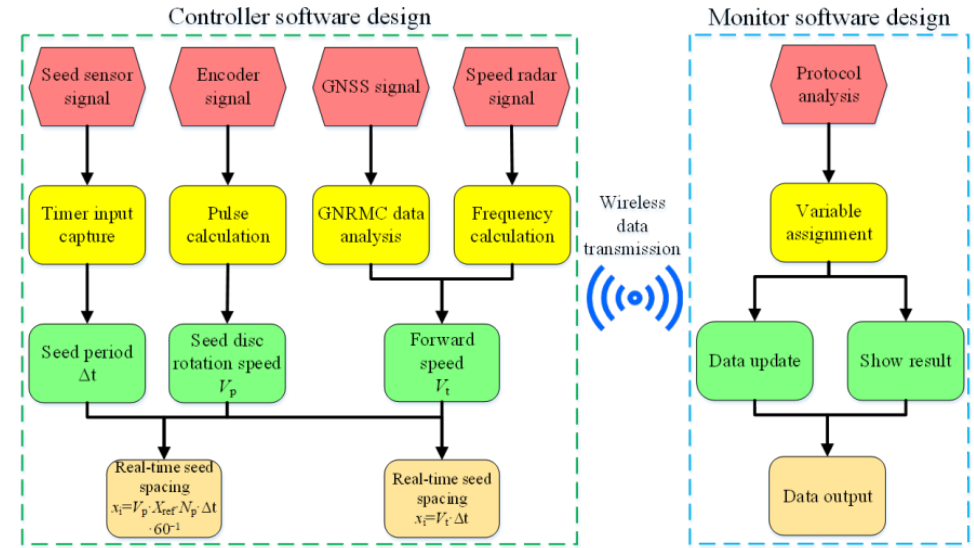
Figure 6. The design of the software function of the monitoring system. The input capture function of the single-chip timer was used to acquire seed sensor signal. It could accurately acquire the period of continuous pulses. Table 3 shows the target time between two seeds at three target seeding spacings and 10 target speeds (the number of seed disc holes was calculated according to 25 cm spacing). Table 3. The calculation result of the target time between two seeds.